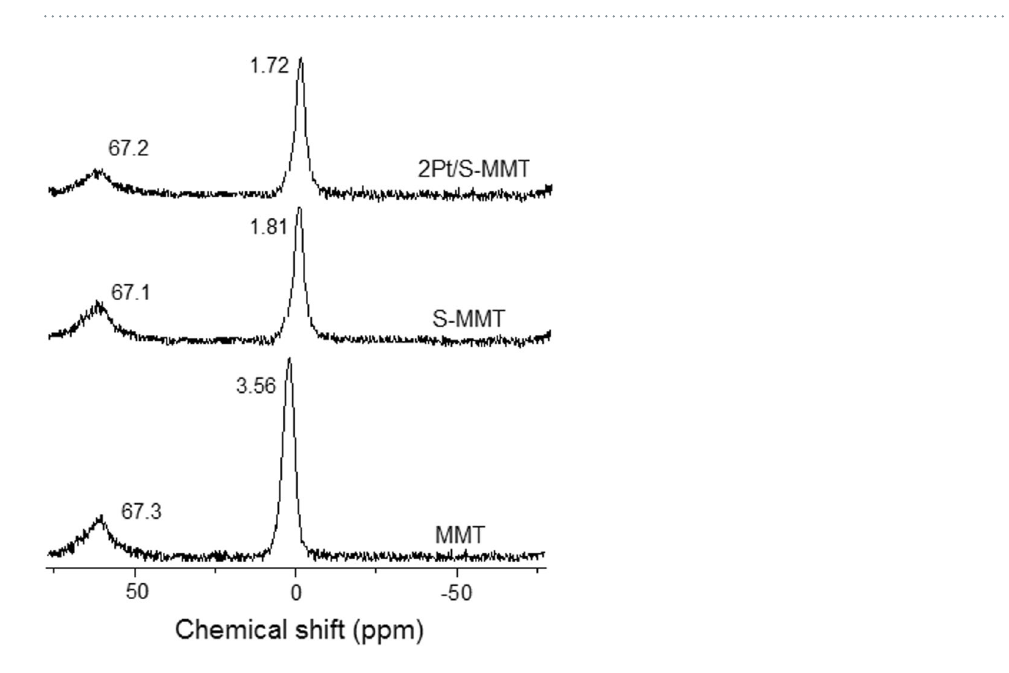
Figure 5. 27 Al NMR spectra of MMT, S-MMT and 2Pt/S-MMT